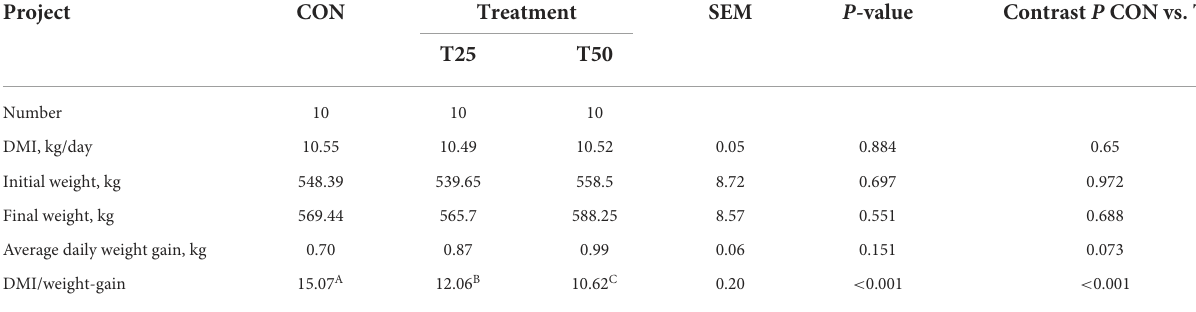
TABLE 3 Effects of different proportions of FPR on cattle